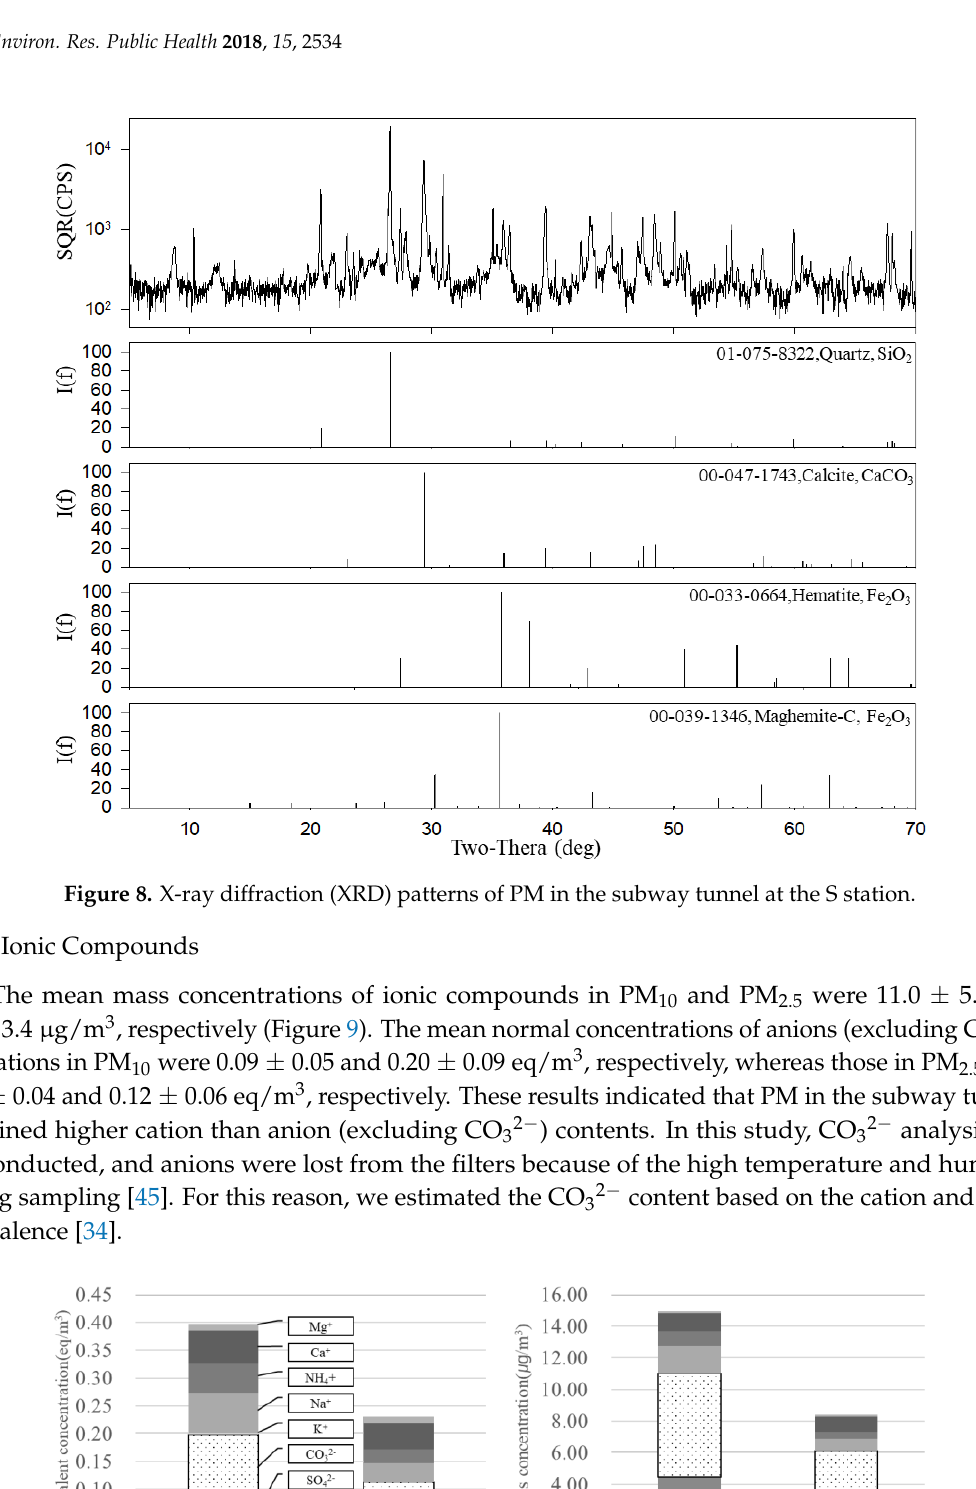
Figure 9. Normal and mass concentrations of ionic components in PM at the M station ( n = 13).